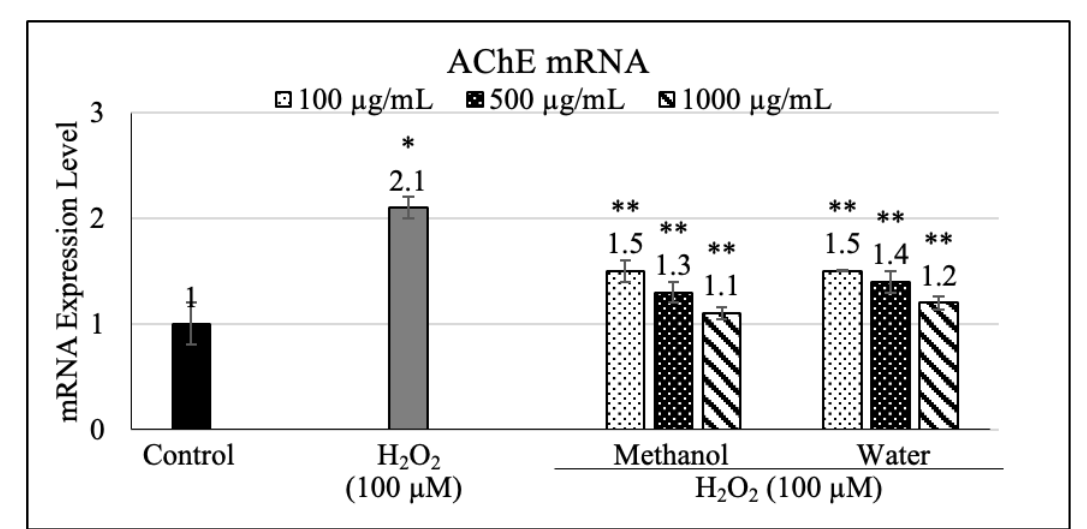
FIGURE 4 - The levels of AChE mRNA expression in dPC12 cells with different concentrations of G. corniculatum after H * p < 0.05 vs. control group. ** p < 0.05 vs. H